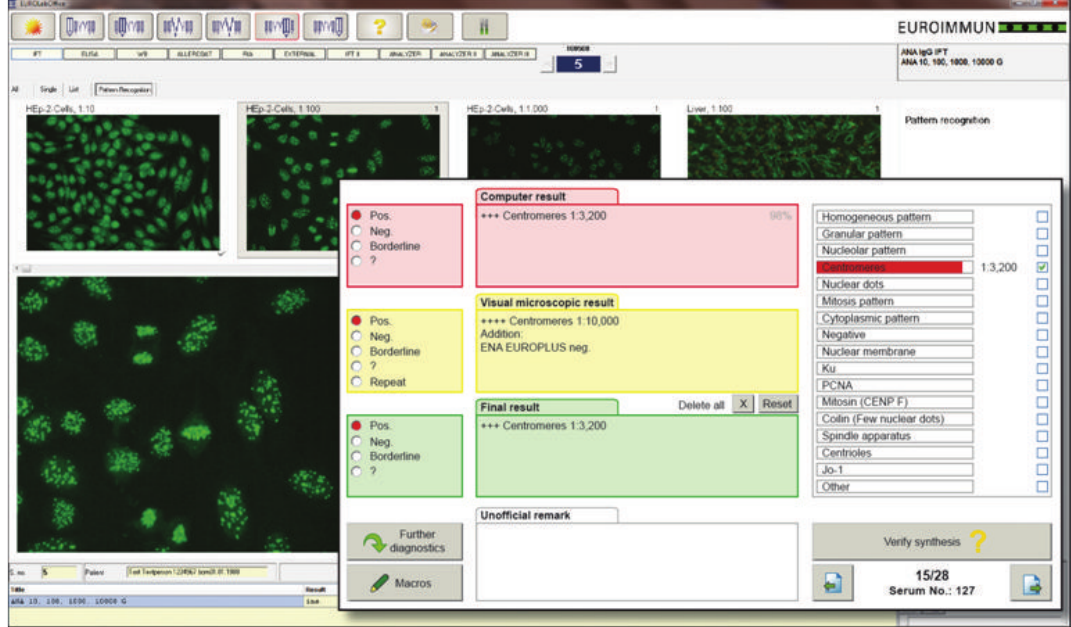
Figure 2: Graphical user interface of EUROPattern. For each patient sample, EUROPattern displays the images of di ff erent sample dilutions, preliminary or additional results, and the software-generated result (recognized pattern, antibody titer, and calculated confidence value) on one report form. The software-generated result can be confirmed by mouse click or, if necessary, modified and specified using a readily displayed list of fluorescence